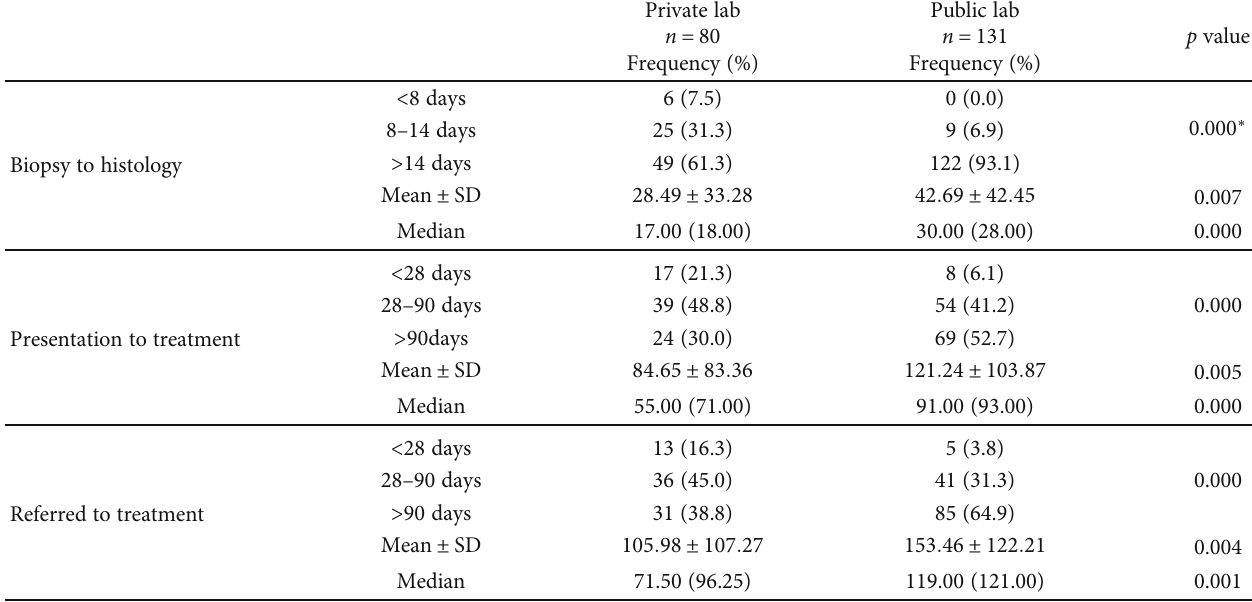
Table 3: Crosstabulation of various timelines with the type of laboratory where histology was